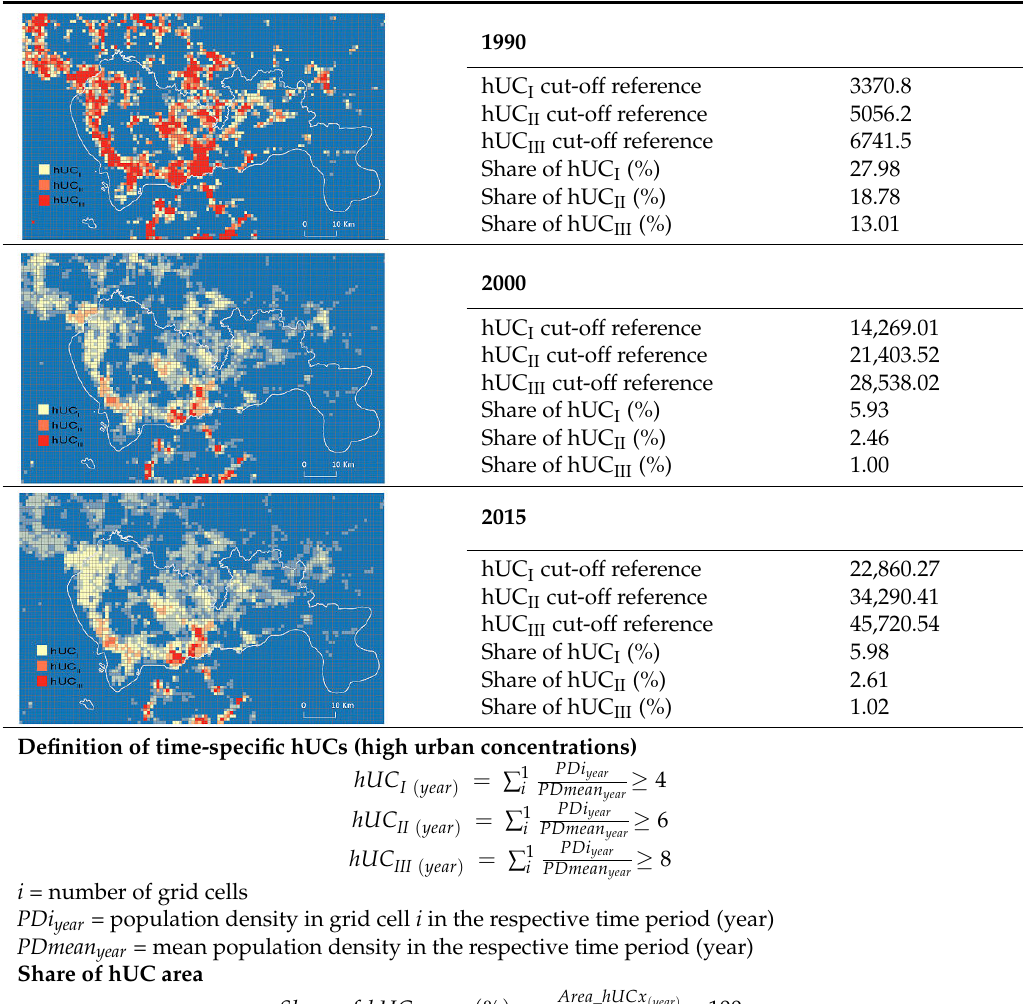
Table 1. Quantitative assessment of polycentricity in Shenzhen in the years 1975, 1990, 2000 and 2014/2015. (Source: Own calculation and visualisation based on GHSL data © EC,